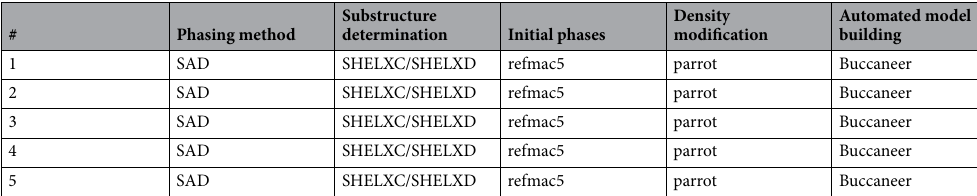
Table 3. Phasing procedure for HEWL datasets.